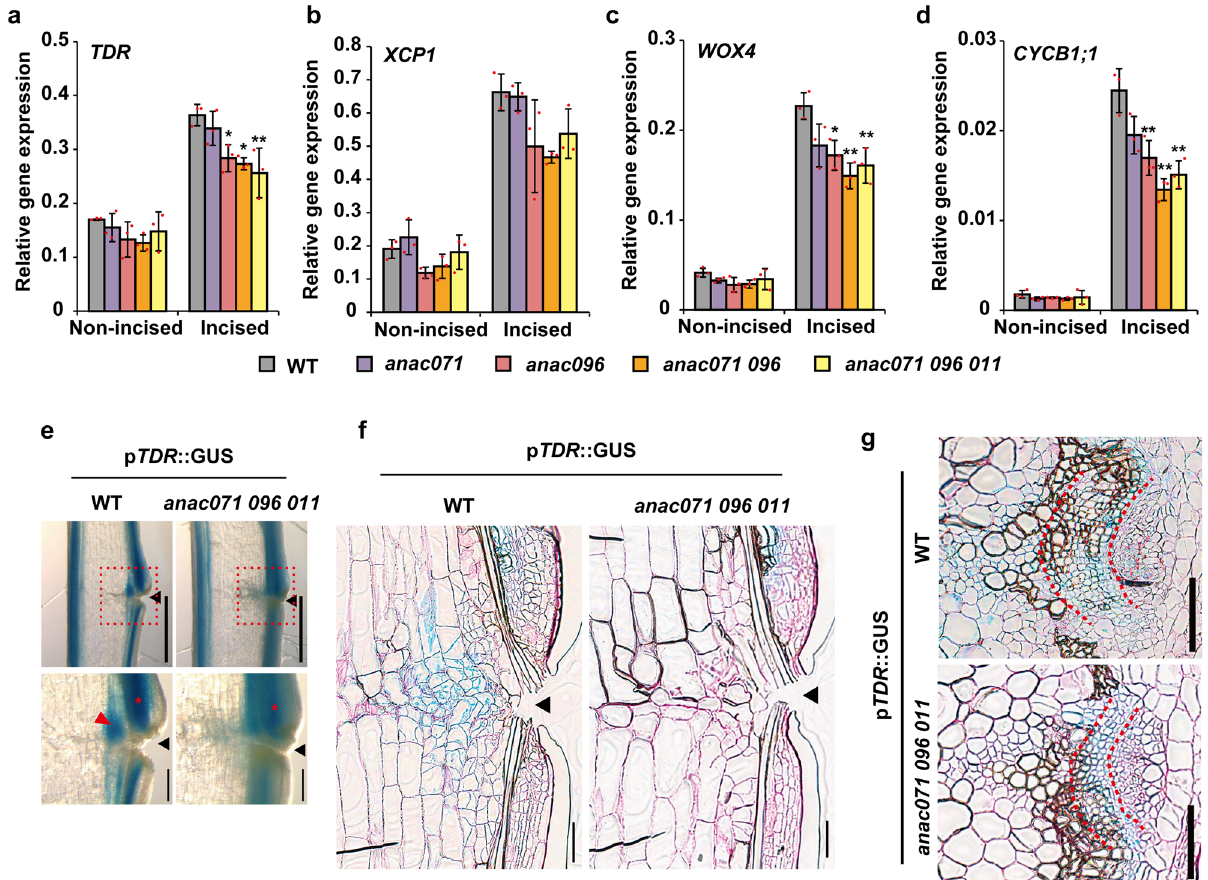
Fig. 7 Comparison of wound-induced cambium between WT and anac mutants. a – d The relative expression levels of TDR/PXY , XCP1 , WOX4 , and CYCB1;1 in fl owering stems were analyzed at 3 DAI. The means± SD of triplicate batch experiments are shown. Statistical analysis was performed using Dunnett ’ s test, in comparison with WT (* p < 0.05). e – g Histochemical p TDR/PXY ::GUS staining in the incised fl owering stems of the WT and the anac071 096 011 triple mutant background at 7 DAI. e Freehand longisections. Scale bars = 1 mm. The regions in red dotted-line boxes are shown at higher magni fi cation (bottom, Scale bars = 200 μ m). Red arrowhead, wound-induced cambium of extravascular region; red asterisks, wound-induced cambium of intravascular region; black arrowheads, incised site. f Thin longisections located between vascular bundles. g Vascular bundles in the upper region of the incision. The area between two red dashed lines indicates wound-induced cambium of intravascular region. Cell walls with red color were counterstained by periodic acid-Schiff. Scale bars = 100 μ